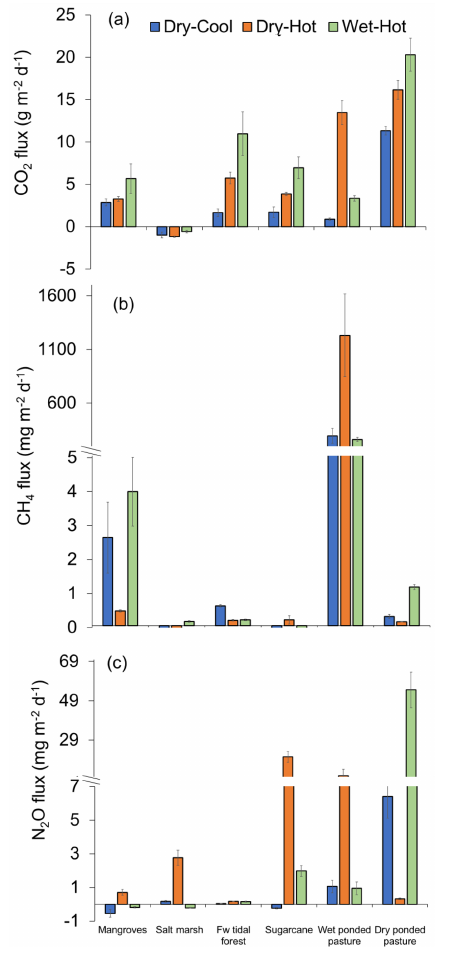
Figure 2. Greenhouse gas fluxes (mgm − 2 d − 1 ) of (a) CO 2 , (b) CH 4 , and (c) N 2 O from the soils of tropical coastal wetlands – mangroves, salt marsh, freshwater (Fw) tidal forest – and two al- ternative land uses – sugarcane and pastures (wet and dry) – during three periods of the year: dry–cool, dry–hot, and